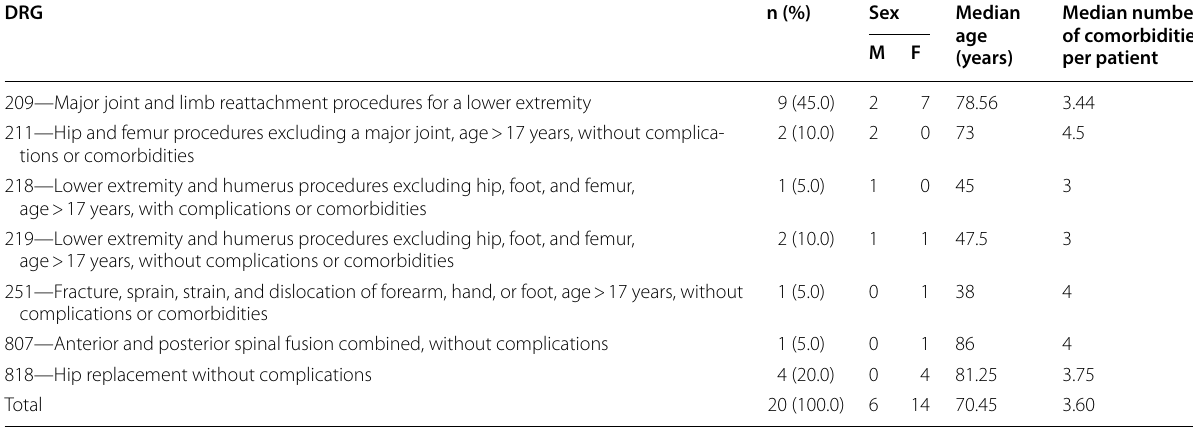
Table 2 Demographic and clinical characteristics of the 20